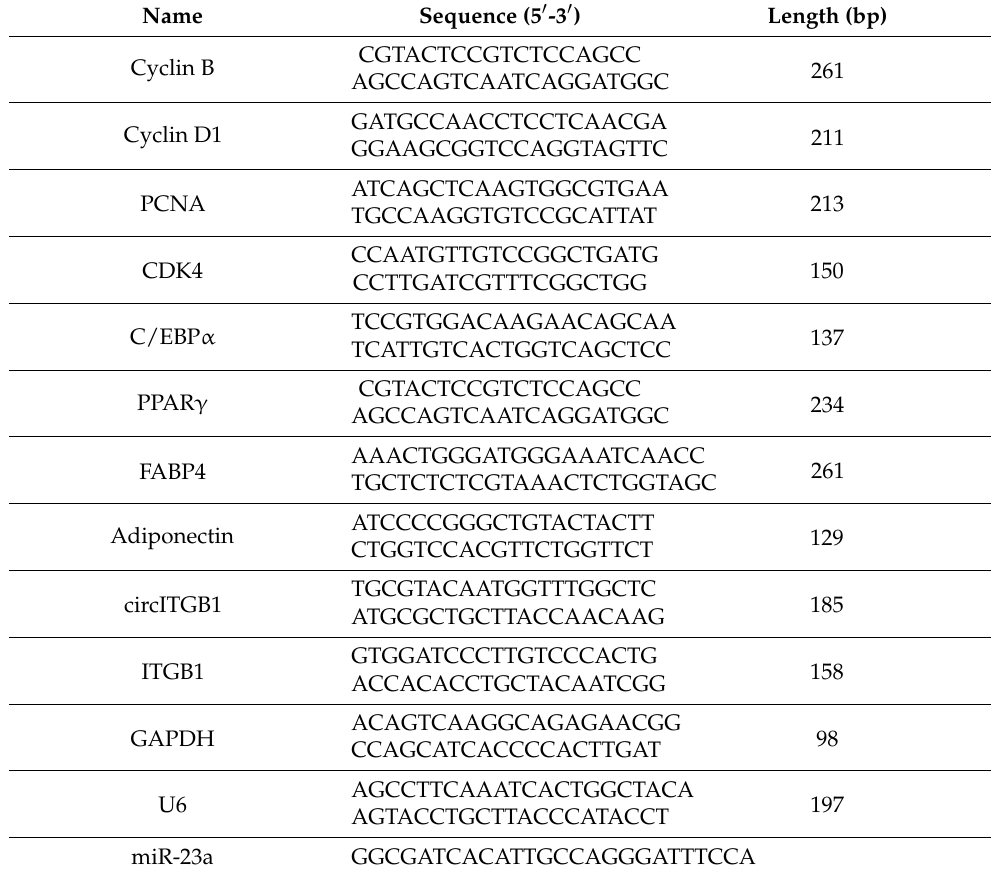
Table 1. Primer sequences for quantitative